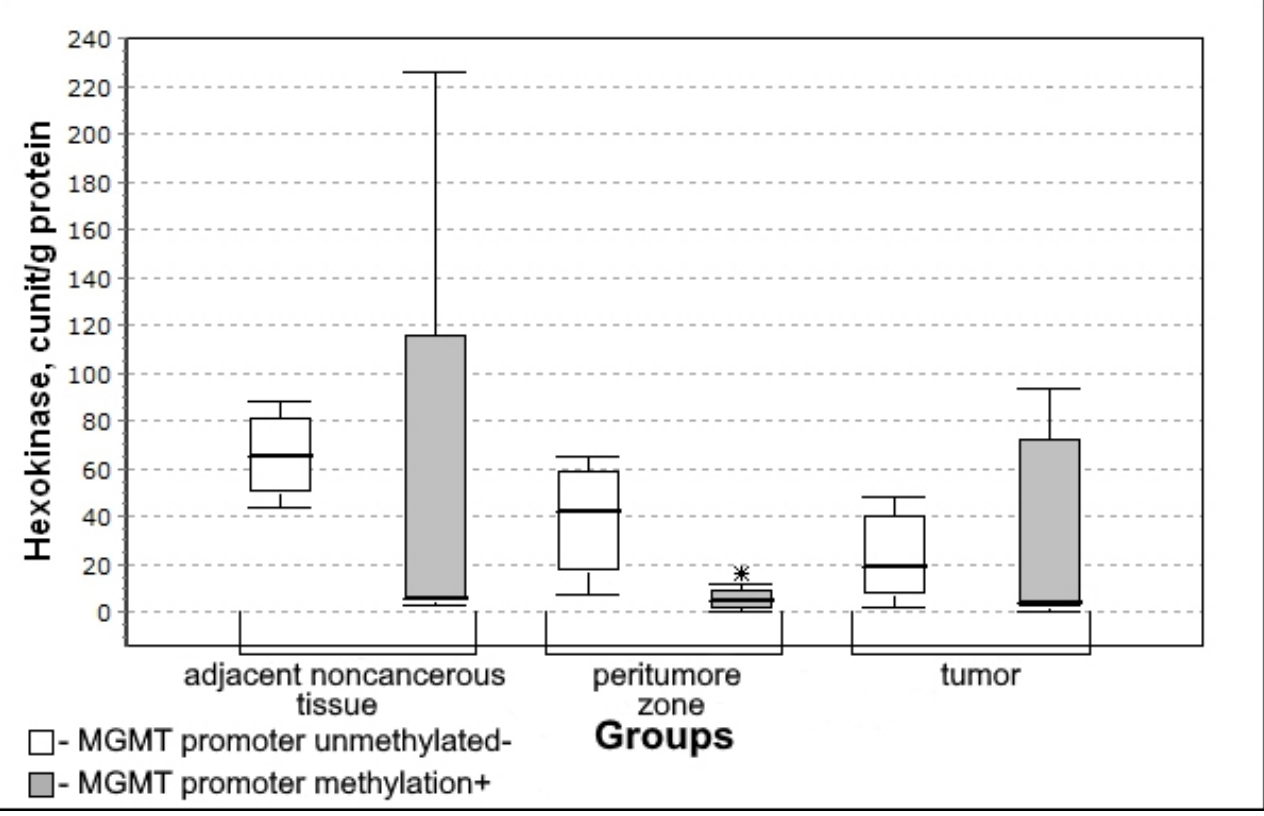
Figure 8. Medians and interquartile ranges (IQR) in the activity of hexokinase in glioma tissue depend on the promoter of the MGMT gene which carries out the DNA repair (MGMT promoter methylation n = 12; MGMT promoter unmethylated n = 8). Statistics are reported * p < 0.05. In the group with MGMT methylation, hexokinase activity in the peritumoral zone was significantly lower (U-criterion of Mann – Whitney p = 0.05; Kolmogorov – Smirnov criterion p = 0.05) than in the absence of methylation of the MGMT gene promoter.